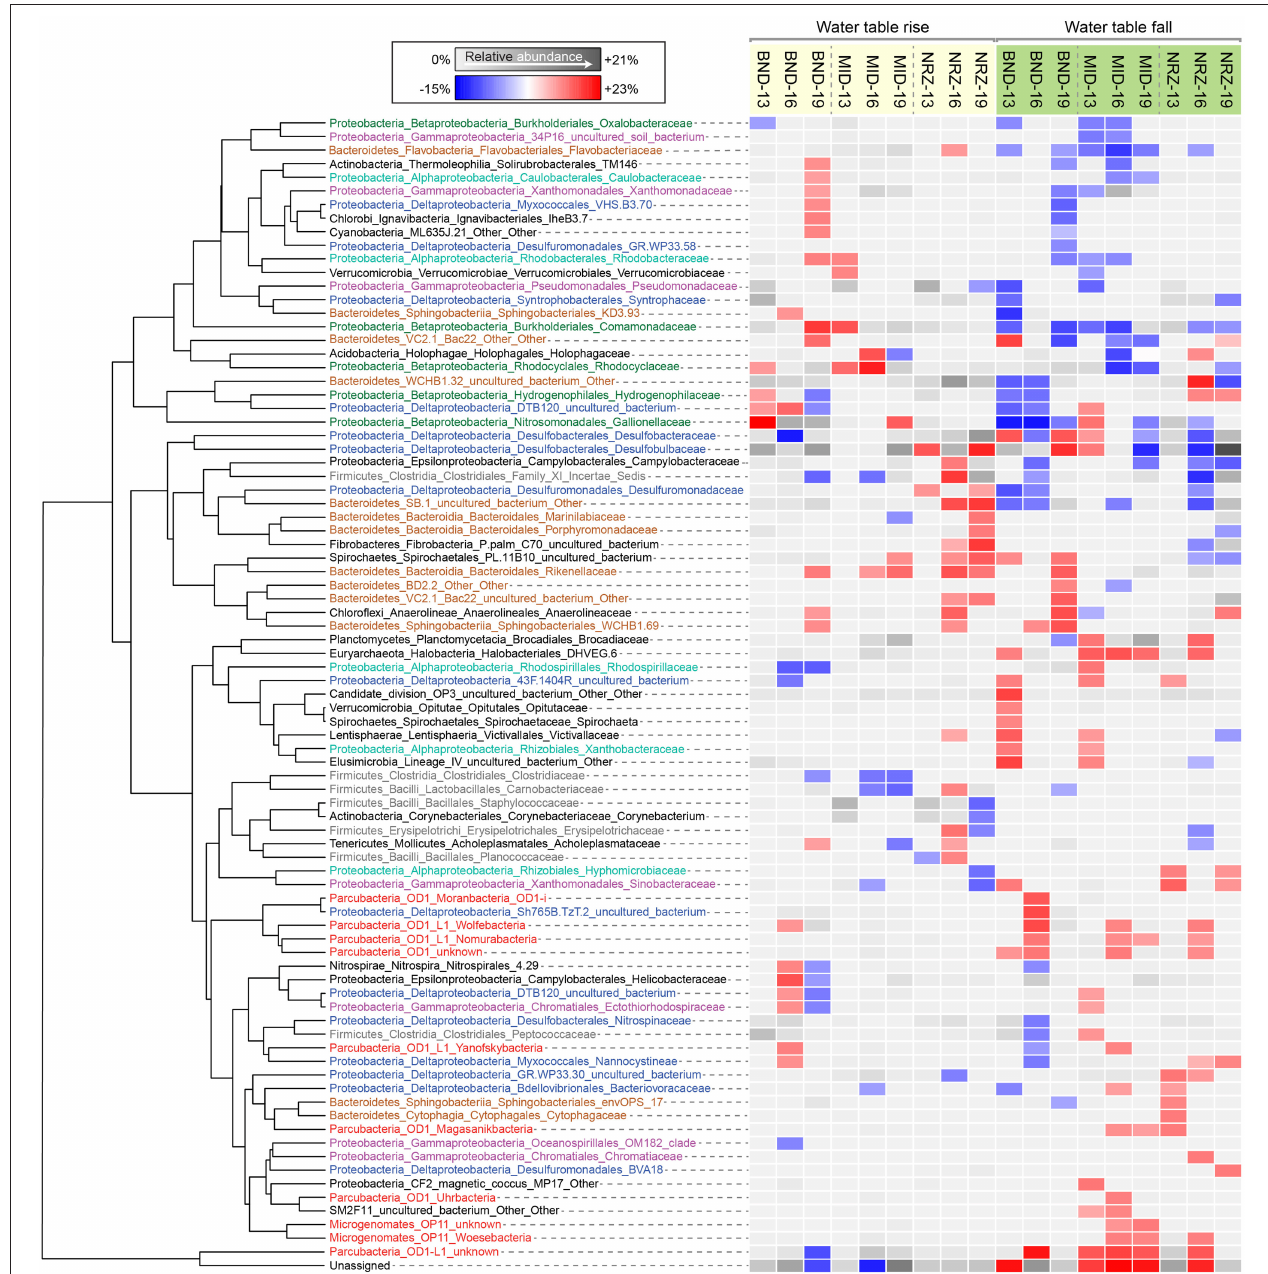
FIGURE 5 | Heatmap illustrating family-level relative abundance responses to fluctuations in water table height, clustered using Euclidean distances. Each of the families displayed had a significant level of correlation ( p < 0.05) to water table rise or fall in at least one sampling location. Either a relative abundance increase or a decrease associated with the significant correlation is indicated by the red-blue color scheme. Not every family responded the same at each location, thus the average relative abundance is indicated by the gray scale when correlations were not